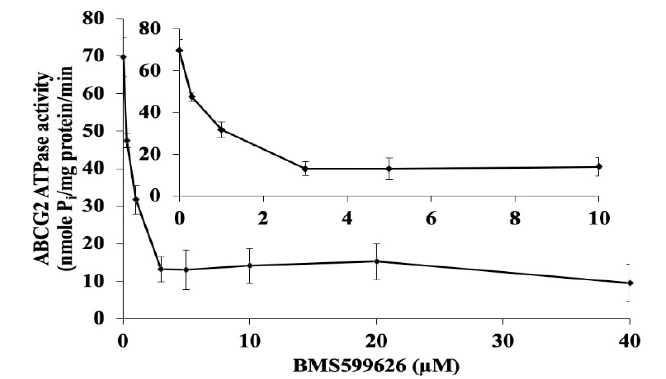
Figure 7. Effect of BMS-599626 on the ATPase activity of ABCG2. The inset shows inhibition of ATP hydrolysis at concentrations of 0–10 µ M BMS-599626. The mean values are plotted, and error bars depict SD obtained from the average of at least three independent experiments.